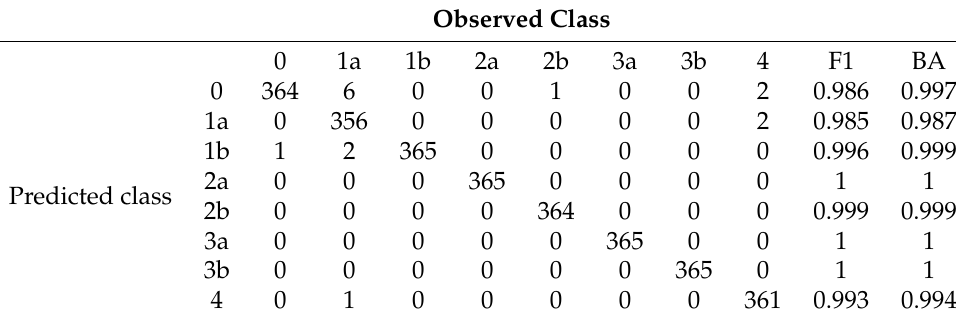
Table 4. Confusion matrix for multi-class classification for the SVM